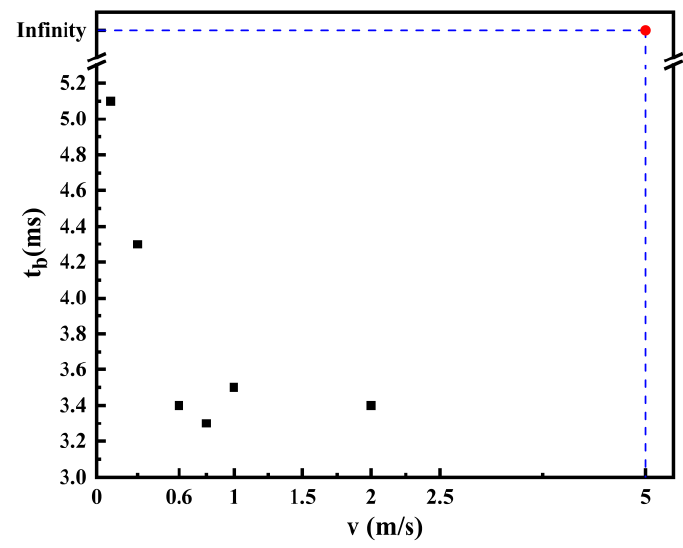
Figure 12. Influence of inlet velocity on bridging time.